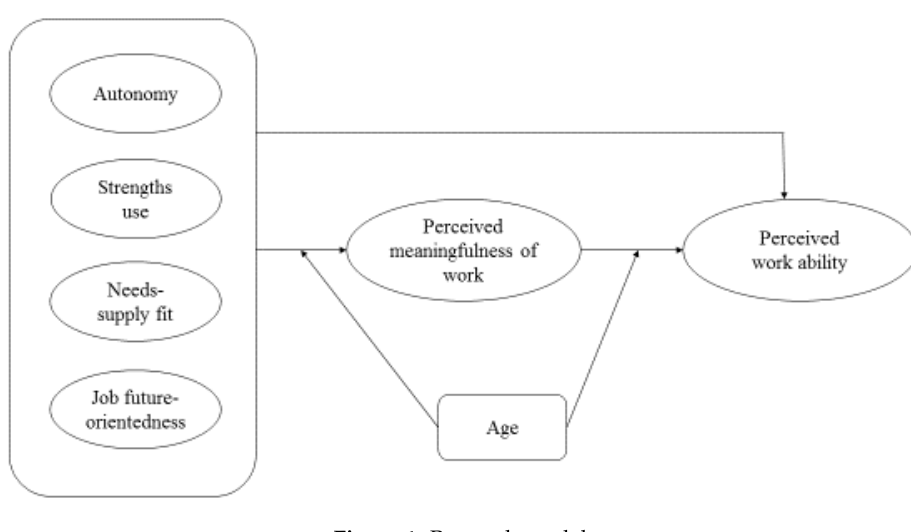
Figure 1. Research Figure 1. Research model.